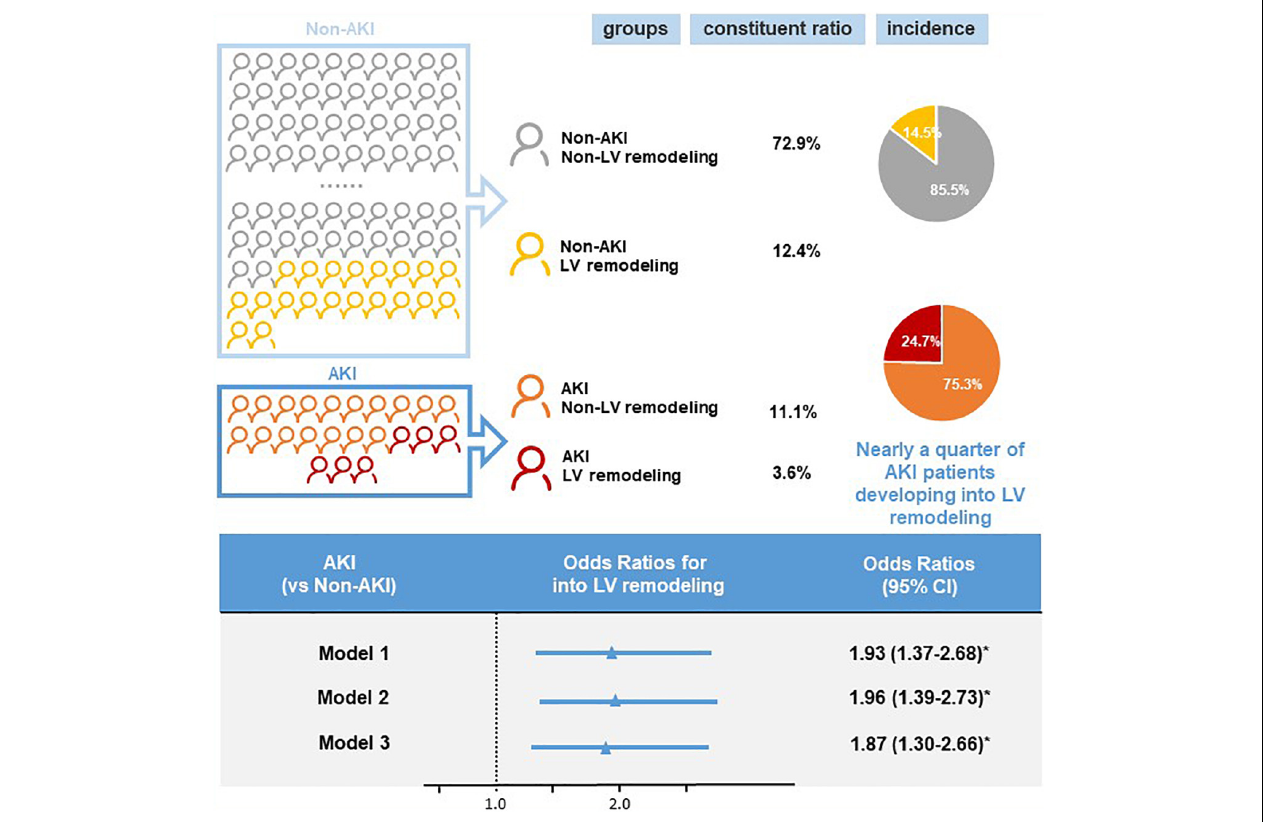
FIGURE 2 | Incidence and risk of left ventricular (LV) remodeling by acute kidney injury (AKI) status. Logistic regression was used to calculate the odds ratios (OR) and 95% confidence intervals (CI) for left ventricular remodeling. Model 1: unadjusted odds ratios for acute kidney injury. Model 2: odds ratios adjusted for age and gender. Model 3: odds ratios adjusted for multiple variables (age, gender, acute myocardial infarction, percutaneous coronary intervention, diabetes, hypertension, chronic kidney disease, angiotensin-converting enzyme inhibitor/angiotensin receptor blocker, contrast medium volume). * p <